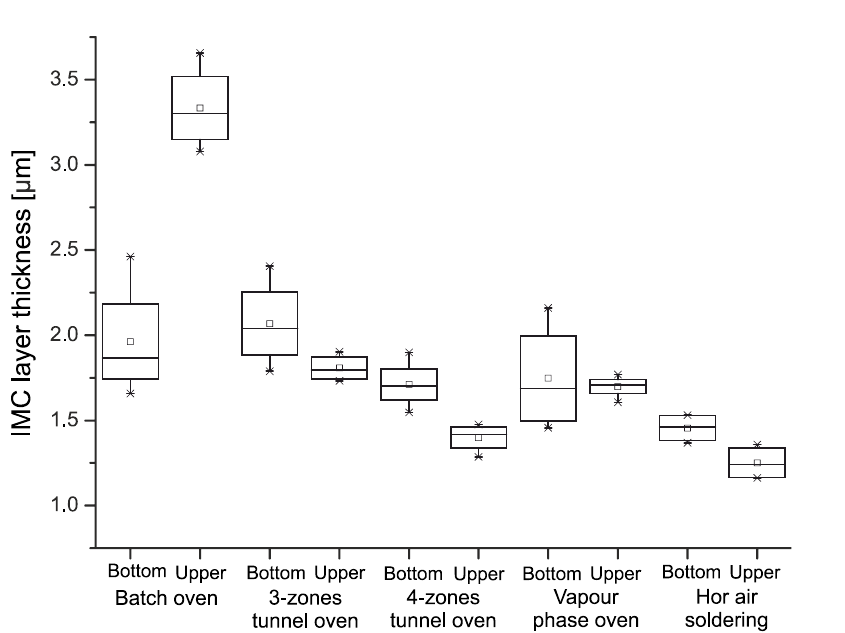
Figure 11. The IMC layer thicknesses of the solder joints soldered in different soldering ovens.